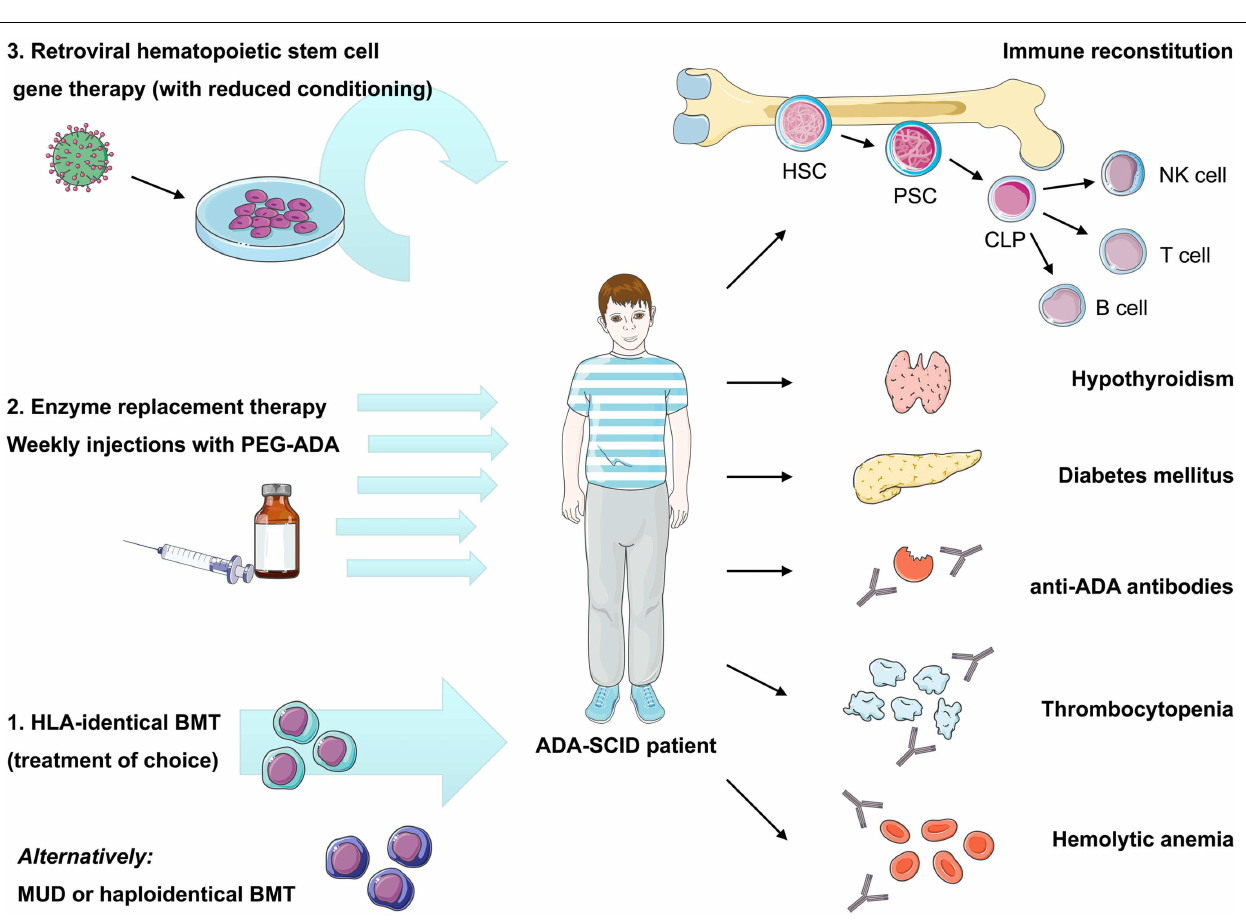
FIGURE 2 | Current therapeutic options inADA-SCID and reported autoimmune manifestations after treatment. Immune reconstitution in ADA deficiency can be achieved by bone marrow transplantation, enzyme replacement, or gene therapy, nonetheless recovery of immune functions may vary depending on the applied treatment and patient’s characteristics.Treatment of choice remains bone marrow transplantation from an HLA-identical sibling donor, while transplants from alternative donors are associated with high morbidity and mortality. Enzyme replacement therapy using pegylated bovine ADA is a non-curative treatment requiring weekly intramuscular injections with PEG-ADA. ADA-SCID has been the pioneer disease for the development